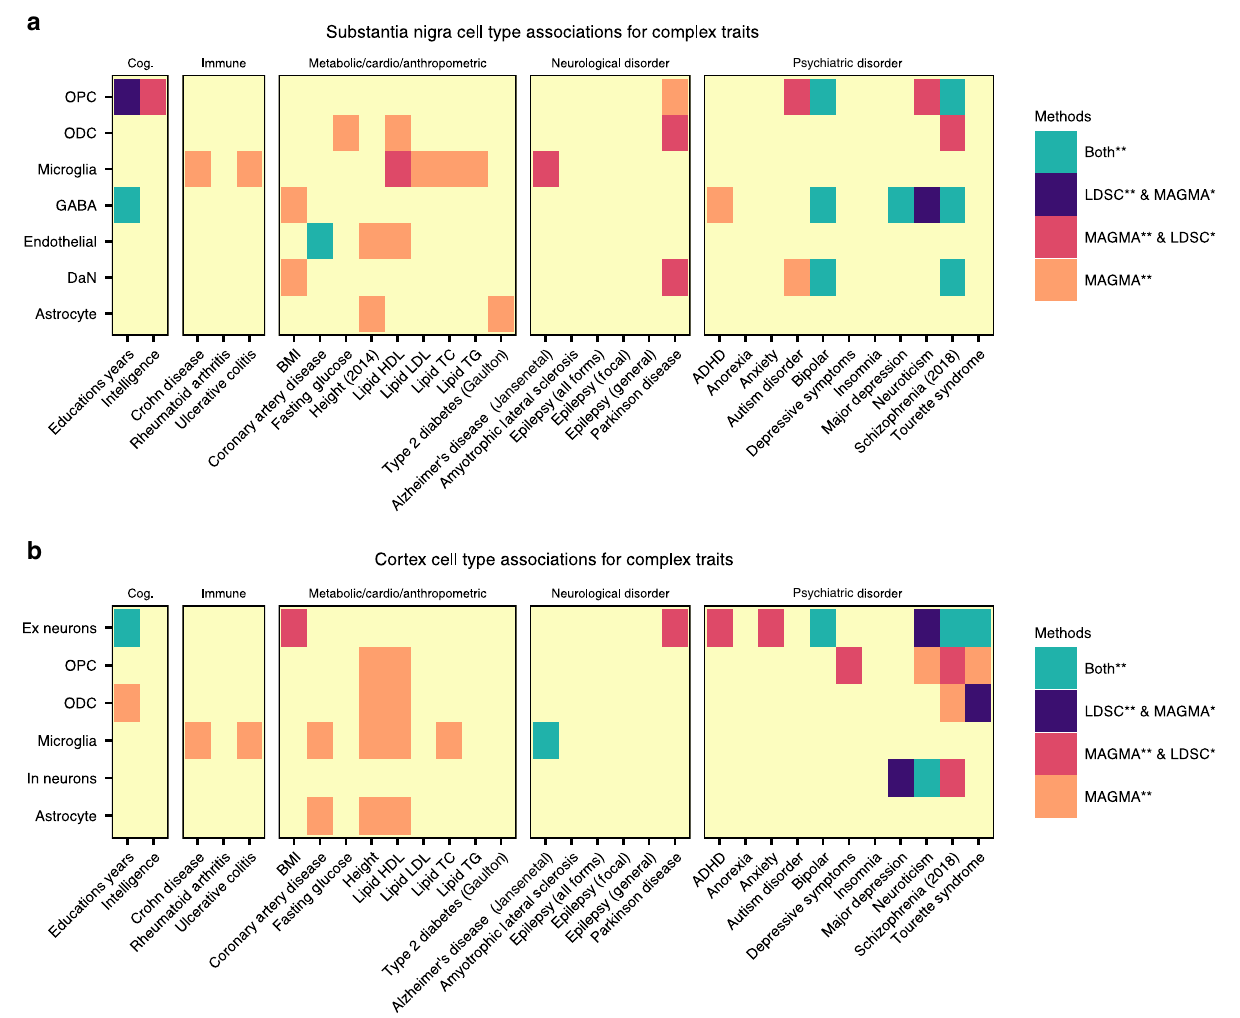
Fig. 2 Identi fi cation of brain cell types associated with diverse human complex traits. We used two approaches to identify the associations between genetic risk variants of different complex trait and cell types from ( a ) substantia nigra and ( b ) cortex: strati fi ed LD score regression (LDSC) ( p value associated with an LDSC Coef fi cient ( “ Methods ” )) and the MAGMA gene set analysis (one-sided positive two-sample t -test). The heatmap colours give different degrees of signi fi cance with both methods or either method, an asterisk (*) and double asterisks (**) indicate nominally signi fi cant p value (<0.05) and q value (Bonferroni correction for the number of cell types tested). The different traits were clustered by category: cognitive phenotypes (Cog.), autoimmune diseases (Immune), metabolic, cardiovascular and anthropometric traits (Metabolic/Cardio/Anthropometric), Neurological disorders, Psychiatric